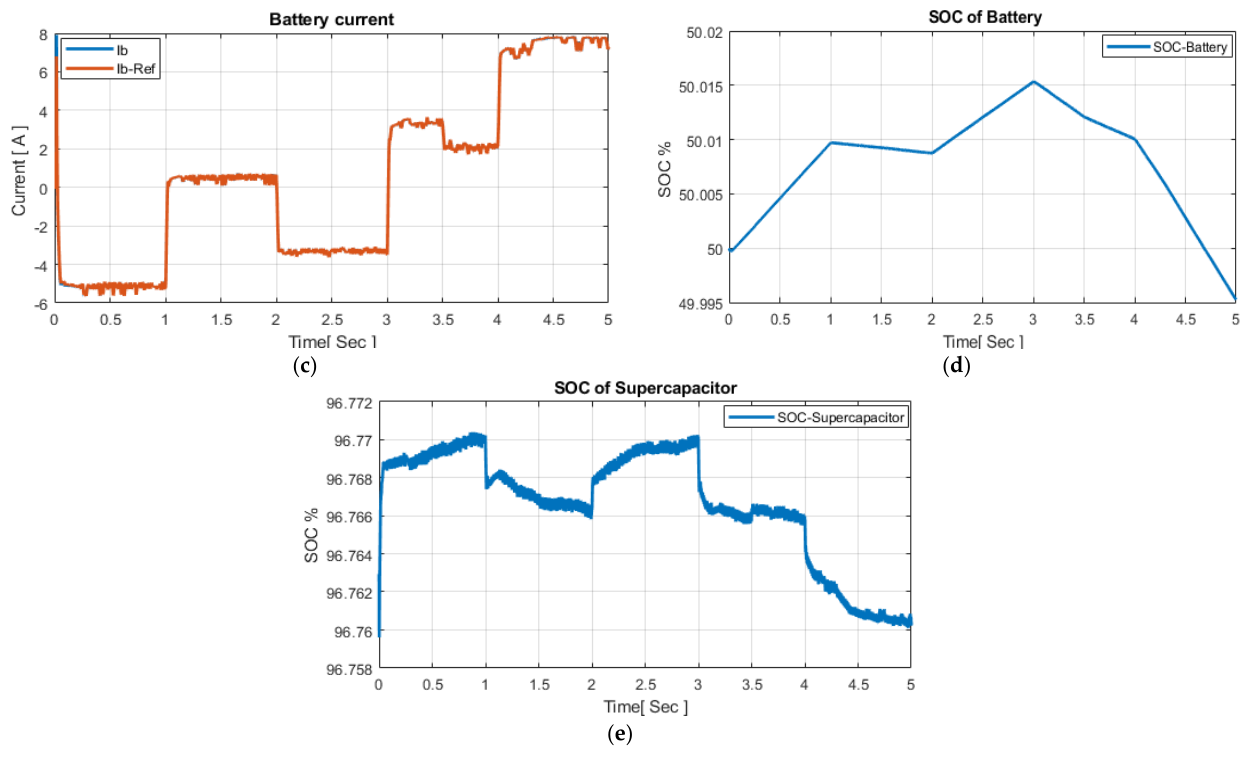
Figure 6. Results with the GWO: ( a ) DC-link voltage; ( b ) power exchange; ( c ) battery current; ( d ) SOC of battery; ( e ) SOC of supercapacitor.